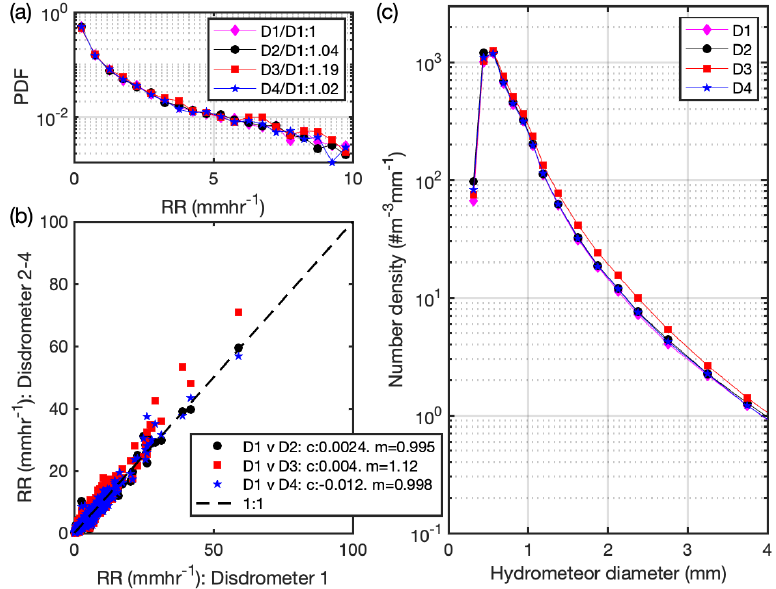
Figure 17. ( a ) Probability distribution and ( b ) Scatterplots of 1 min rainfall rates (RR, in mmhr − 1 ) from the four OTT Parsivel 2 disdrometers (D1, D2, D3, D4) operating at Cornell University during the first instrument closure experiment. The probability distribution of RR shown in panel ( a ) is discretized into 0.5 mmhr − 1 intervals and the legend reports the mean ratio of RR from the disdrometers. The legend in ( b ) denotes best-fit lines to the datasets where c is the intercept and m is the slope of a linear fit. ( c ) Mean DSD from the four instruments for all 8526 1 min periods when RR > 0 mmhr − 1 .